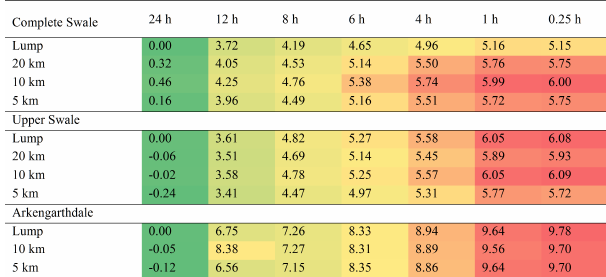
Table 8. The percentage deviations for each catchment of the mean annual sediment yield outputs using different spatio-temporal reso-